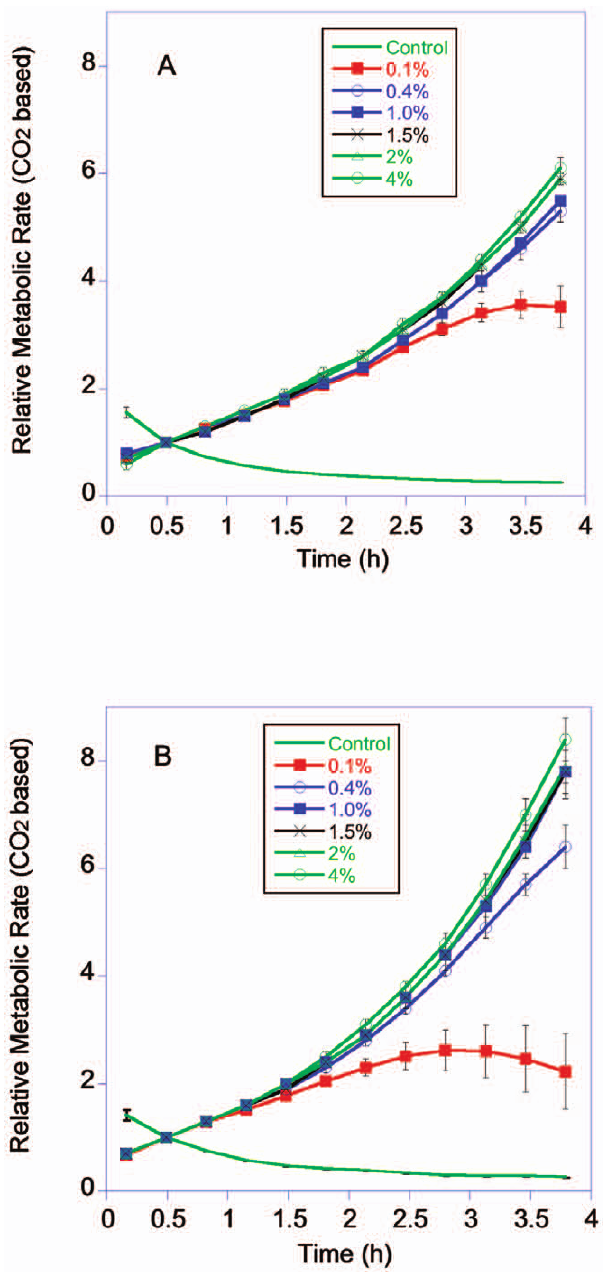
Figure 3. Relative metabolic rate of BY (3A) and RM (3B) grown in YP with a starting concentration of 0.1 to 4% dextrose based on CO 2 production. Figures 3 – 6 are plotted using the means and sem of 6 groups. The metabolic rate data were normalized to a value of 1.0 at the 2 nd metabolic reading. doi:10.1371/journal.pone.0030053.g003 4% dextrose (CO 2 ANOVA, F= 4.6, P =0.003, df =5; O 2